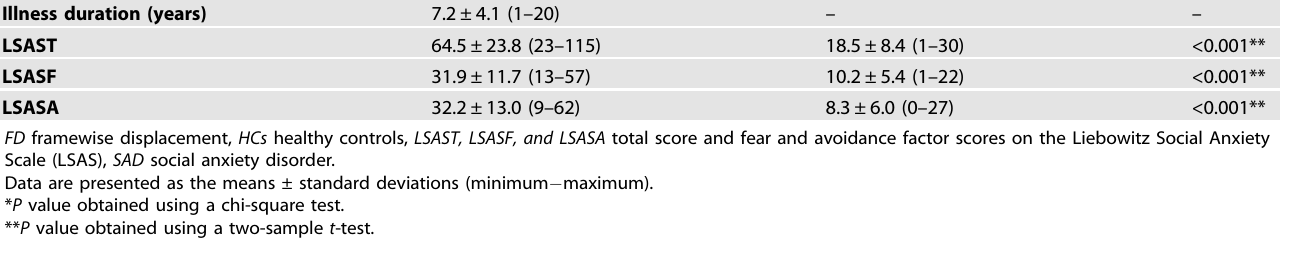
Table 1. Demographics and clinical characteristics of participants.